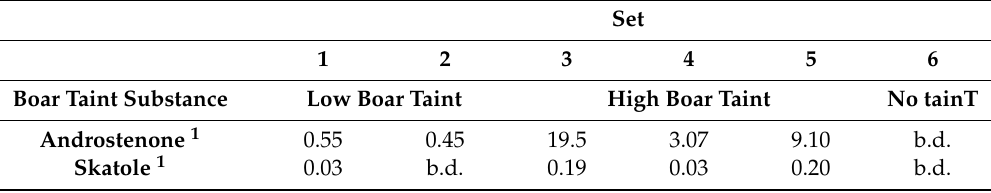
Table 1. Level of boar taint substances in the fat tissue of entire males (EM).